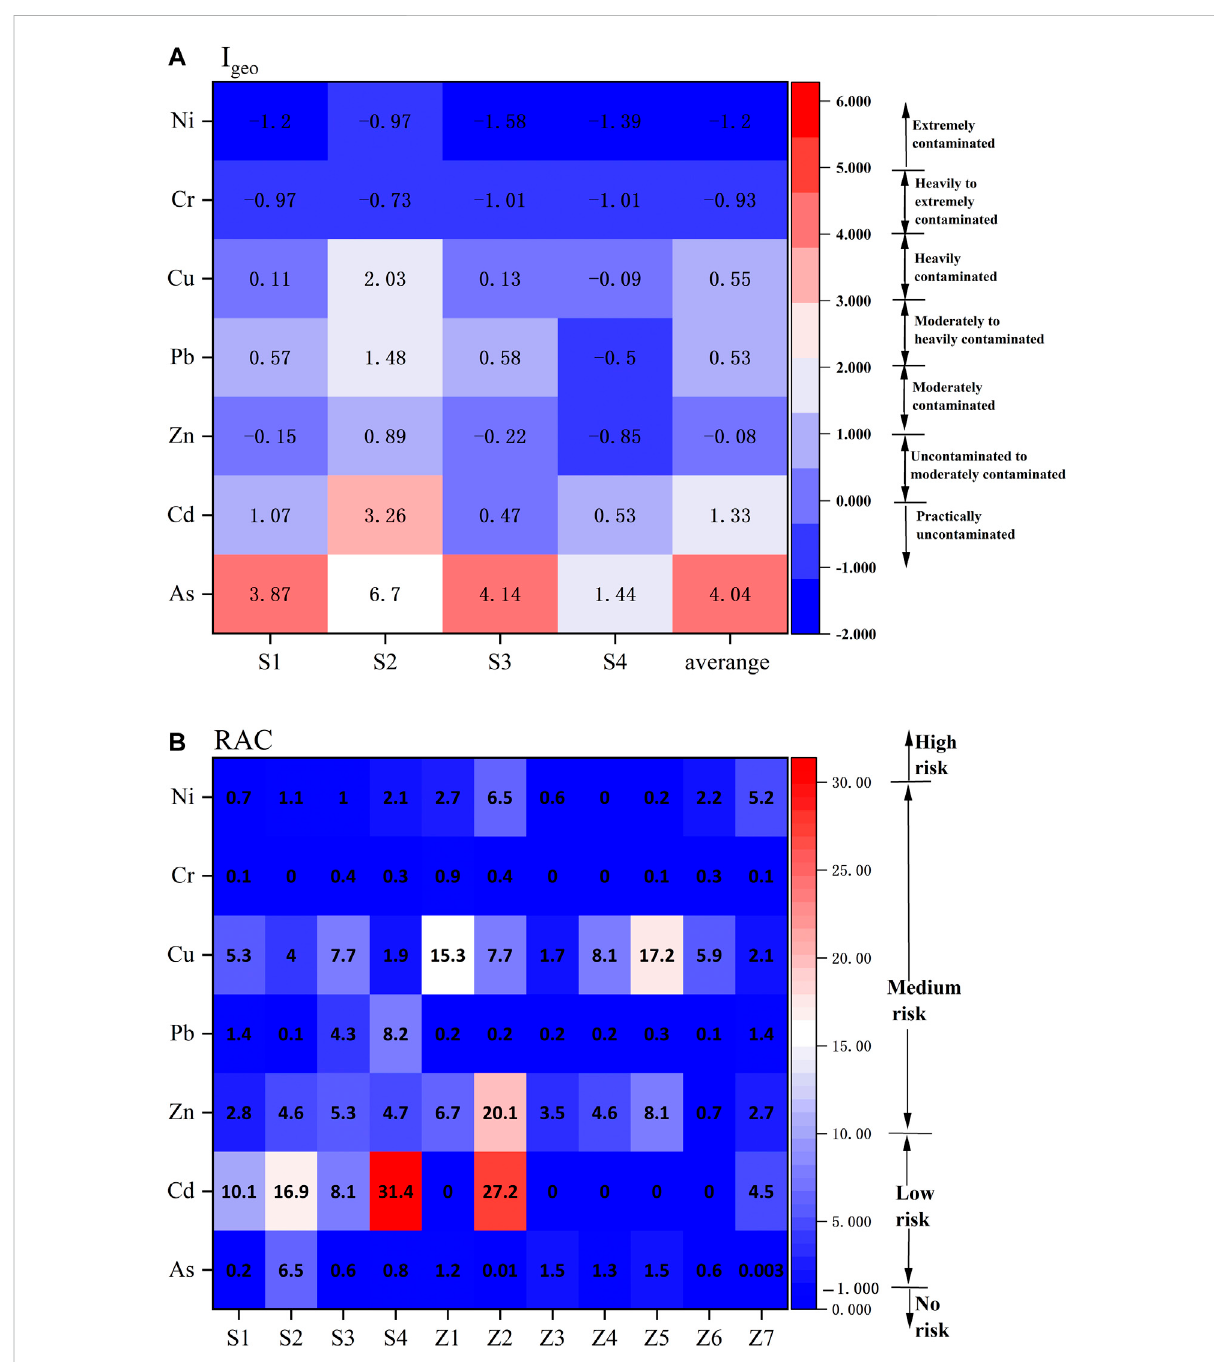
FIGURE 8 Risk assessment of soil, tailings, and sludge by I geo . (A) and RAC (B)